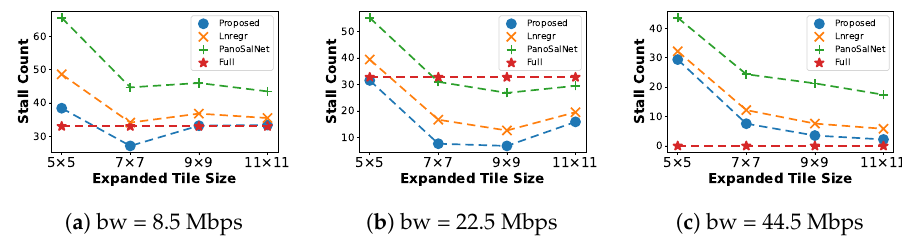
Figure 4. Buffer Stall Count under different bandwidth